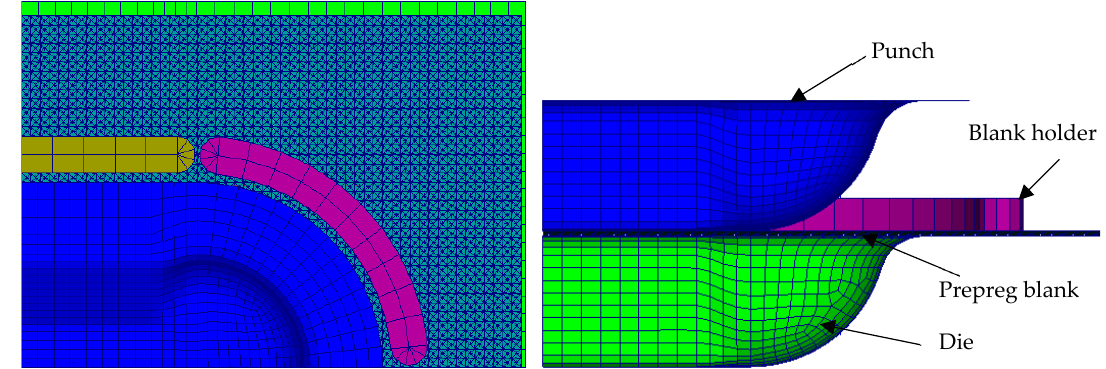
Figure 10. Double dome structure (geometry and mesh).